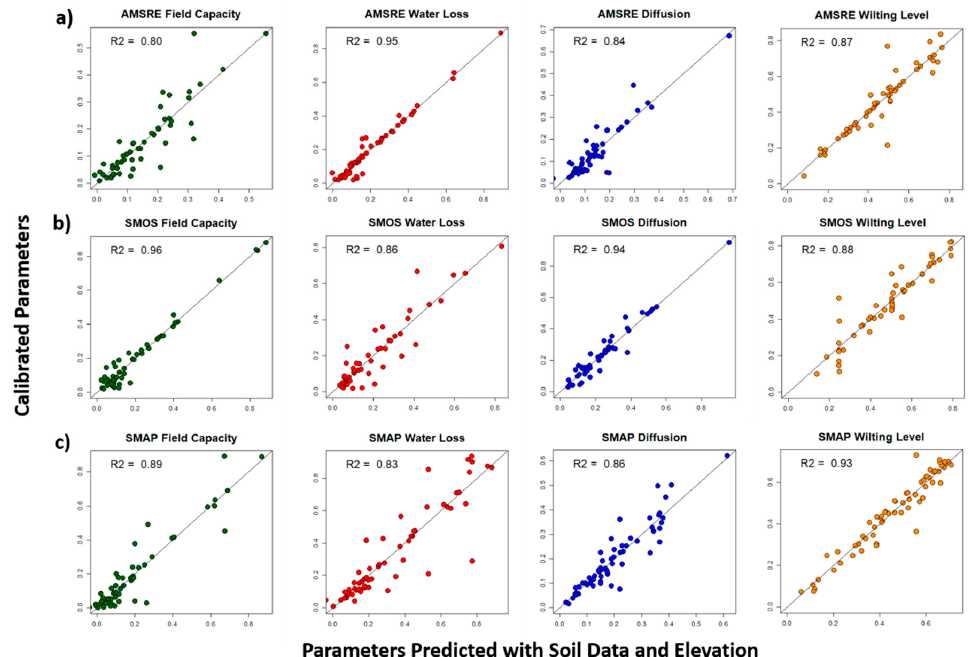
Figure 5. Scatterplots showing the 1:1 relationship between calibrated SMAR parameters and predictions of SMAR parameters from a neural network model and CONUS soil property data. The graphs are arranged by the parameters (left to right): S C1 , a , b , and S W for ( a ) AMSRE-, ( b ) SMOS-, and ( c ) SMAP-estimated parameters.